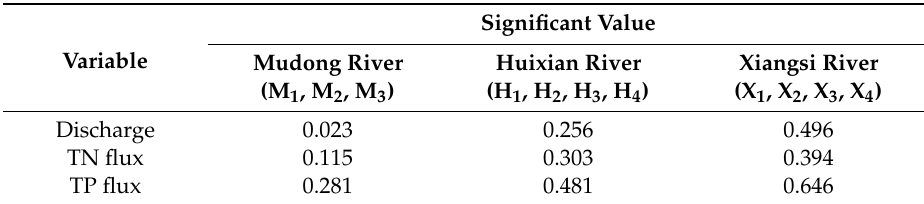
Table 7. The significant value of discharge, TN and TP flux variation within the three investigated rivers calculated using the one-way